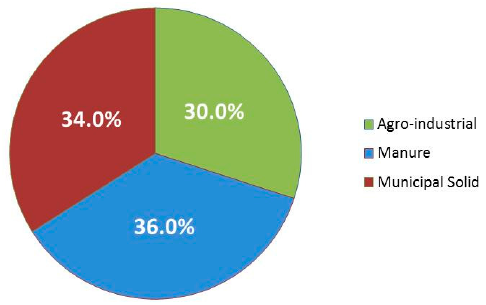
Figure 1. Distribution of waste sources for anaerobic digestion [15].